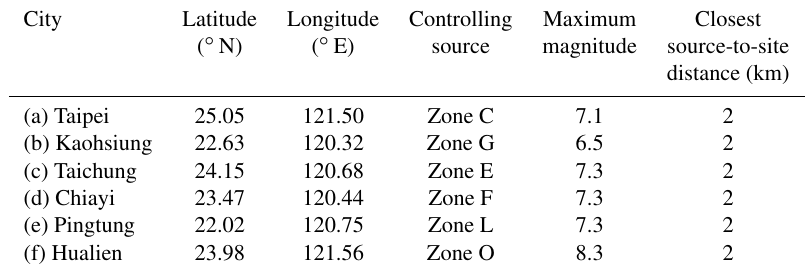
Table 3. Summary of the sites’ coordinates, along with respective controlling seismic sources for each site in DSHA computations.